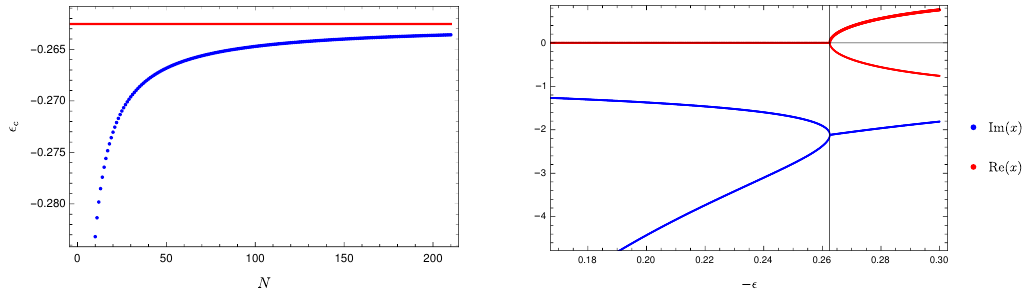
Figure 19 . The critical points (cid:15) c ( N ) computed perturbatively using the polynomial approxima- tions (5.14) of order 2 N + 2 (blue line) converges to the “exact” critical point (cid:15) c ≈ − 0 . 2625 (flat red line) of the full equation (5.10) (left panel). The dependence of real and imaginary parts of the root x on (cid:15) (right panel). The level-crossing occurs at (cid:15) c ≈ − 0 . 2625 . The same transition in the complex x -plane is shown in figure